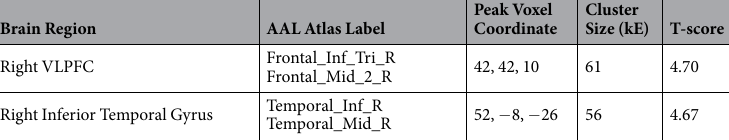
Table 4. Conjunction Analyses.